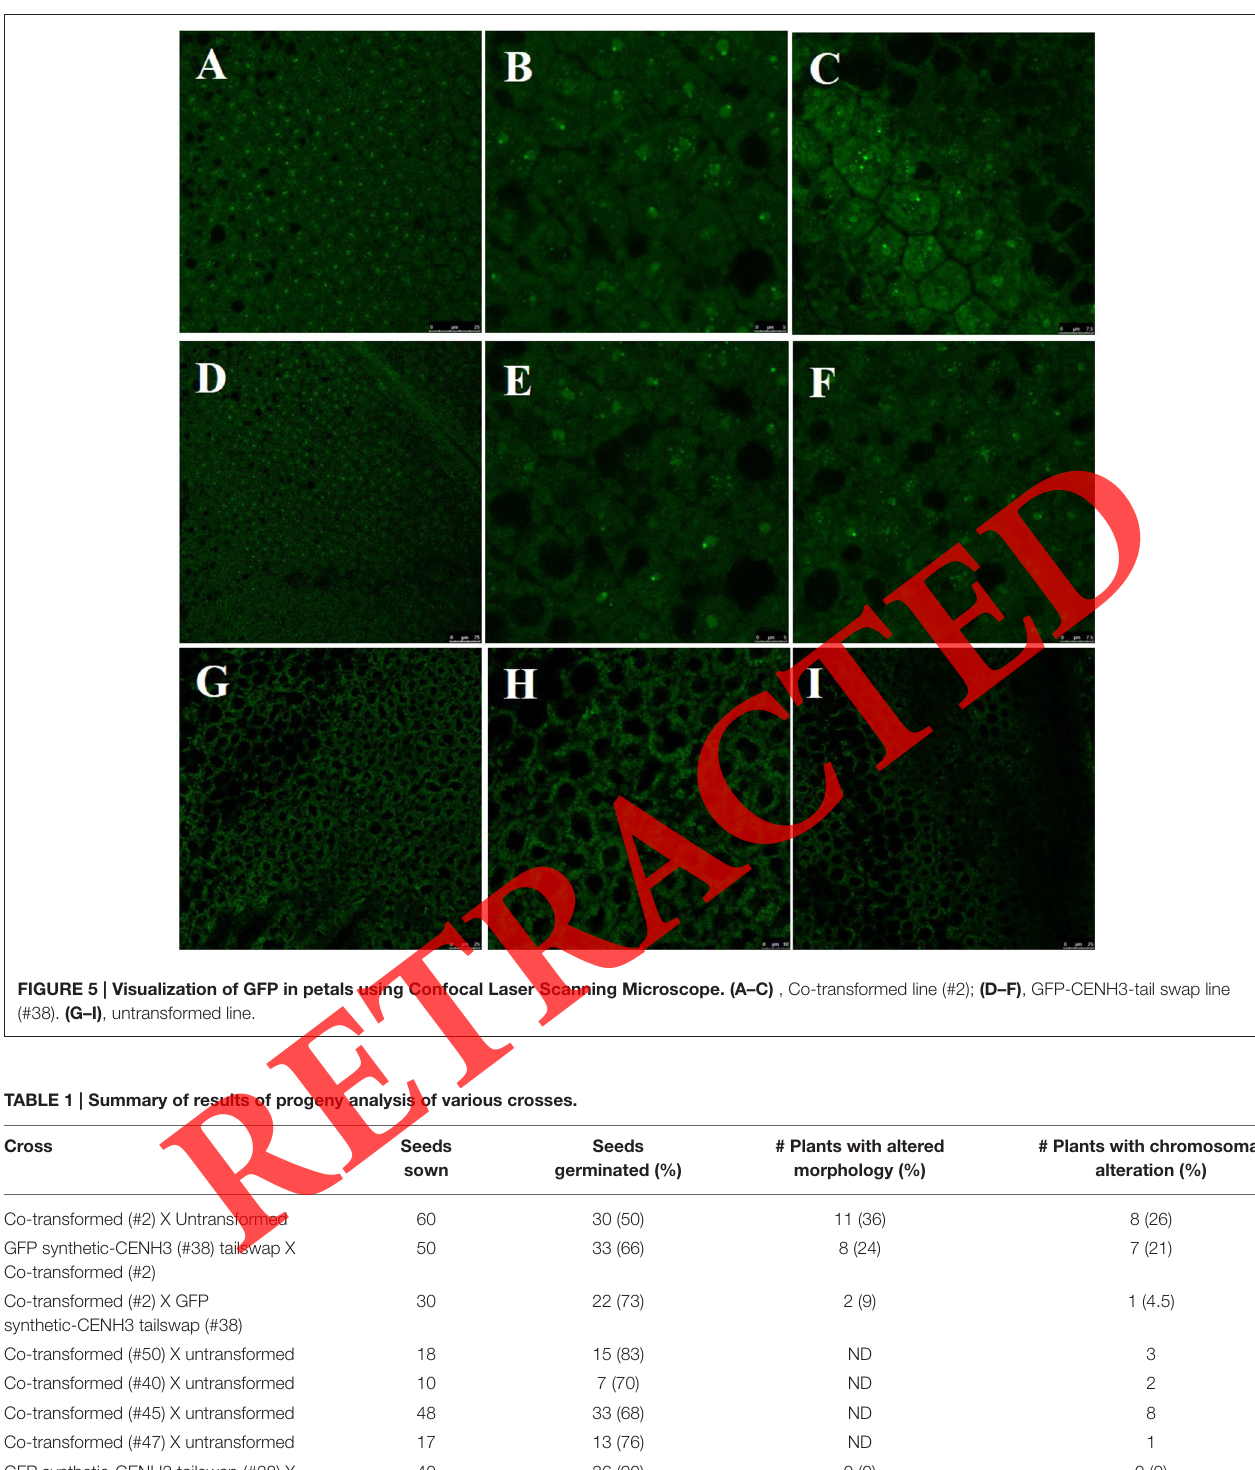
R TABLE 1 | Summary of results of progeny analysis of various crosses. Cross Seeds Seeds # Plants with altered # Plants with chromosomal sown germinated (%) morphology (%) alteration (%) Co-transformed (#2) X Untransformed 60 30 (50) 11 (36) 8 (26) GFP synthetic-CENH3 (#38) tailswap X 50 33 (66) 8 (24) 7 (21) Co-transformed (#2) 30 22 (73) 2 (9) 1 (4.5) Co-transformed (#50) X untransformed 18 15 (83) ND 3 Co-transformed (#40) X untransformed 10 7 (70) ND 2 Co-transformed (#45) X untransformed 48 33 (68) ND 8 Co-transformed (#47) X untransformed 17 13 (76) ND 1 GFP synthetic-CENH3 tailswap (#38) X 40 36 (90) 0 (0) 0 (0) Untransformed Overall 275 189 (68.72) – 30 (19.61)*